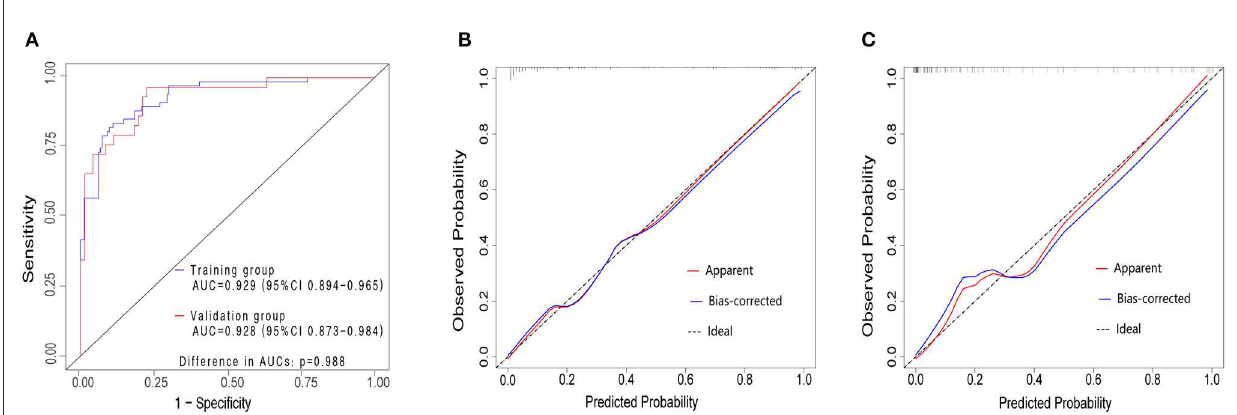
FIGURE3 ROC curves in both the training and validation cohorts (A) . Training group (blue curve), AUC = 0.929 (95%CI 0.894–0.965). Validation group (red curve), AUC = 0.928 (95%CI 0.873–0.984) The AUCs for the OSA in COPD consecutive patients in the training and validation group exceed 0.7, which demonstrated that the nomogram could accurately predict the risk of OSA in consecutive patients with COPD. Calibration plot in the training group (B) and validation group (C) . The y-axis represents the actual probability of patients with OSA as validated by the sleep monitoring study, and the x-axis represents the predicted risk of OSA by the risk nomogram. The dotted line represents a perfect prediction by an ideal model, while the blue line represents the performance of the risk nomogram. A closer fit of the blue line to the dotted line represents a better prediction. COPD, chronic obstructive pulmonary disease; OSA, obstructive sleep apnea syndrome; ROC, receiver operating characteristic curves; AUC, area under the ROC curve; CI, confidence interval.